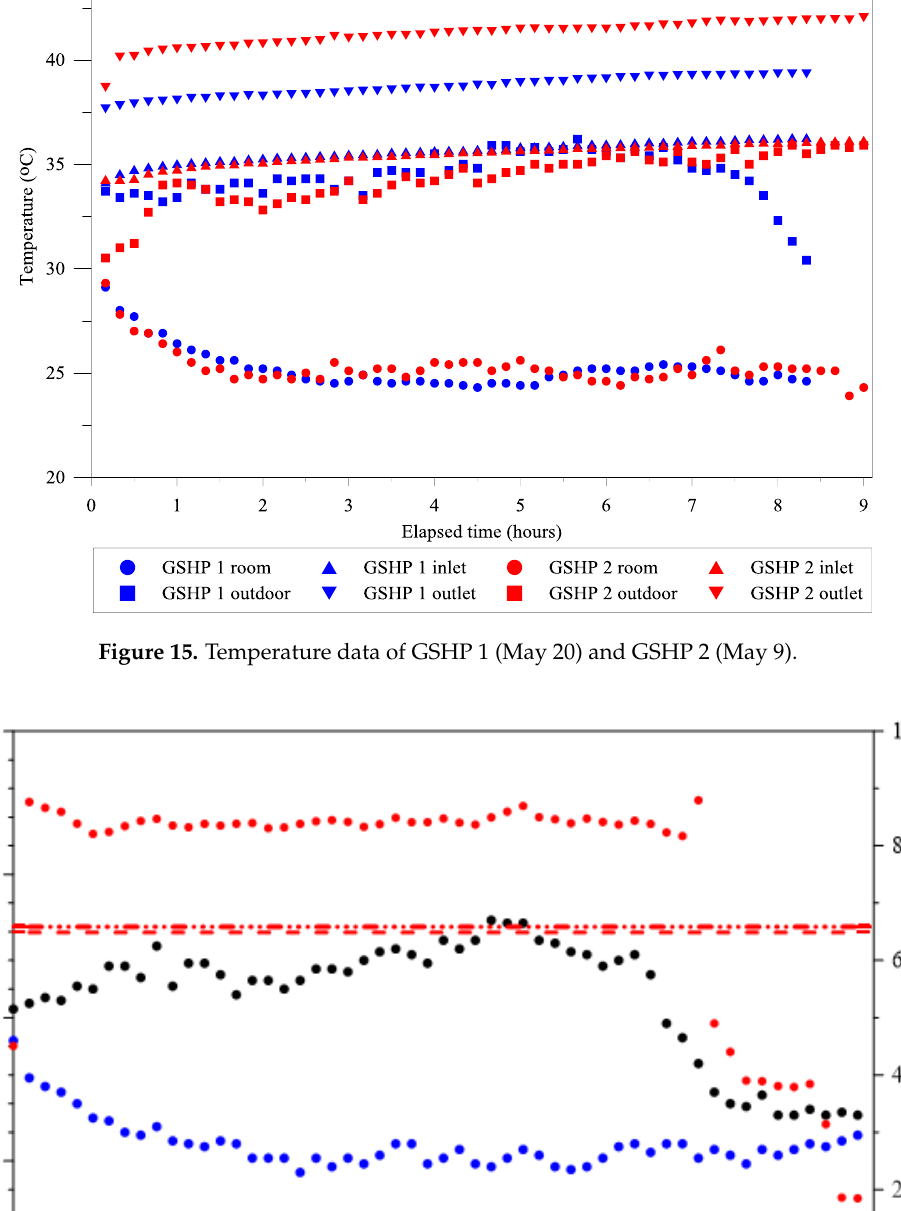
13 of 22 Figure 14. Performance comparison of the GSHPs and ASHP; the coefficient of performance (CoP) of the ASHP is calculated assuming an average cooling load similar to that of GSHP 1 and GSHP 2. Figure 16 shows the performance of the ASHP. During operation at a high outdoor temperature, the ASHP required a power input higher than the average power consumption of GSHP 1 and GSHP 2. However, as soon as the outdoor temperature dropped below 27.5  C, after about 7 hours of operation, the power consumption fell below the average value for GSHP 1 and GSHP 2. This temperature range is a turning point, where one may consider that the application of a GSHP has no advantage over the application of an ASHP. There is a close relationship between thermal comfort